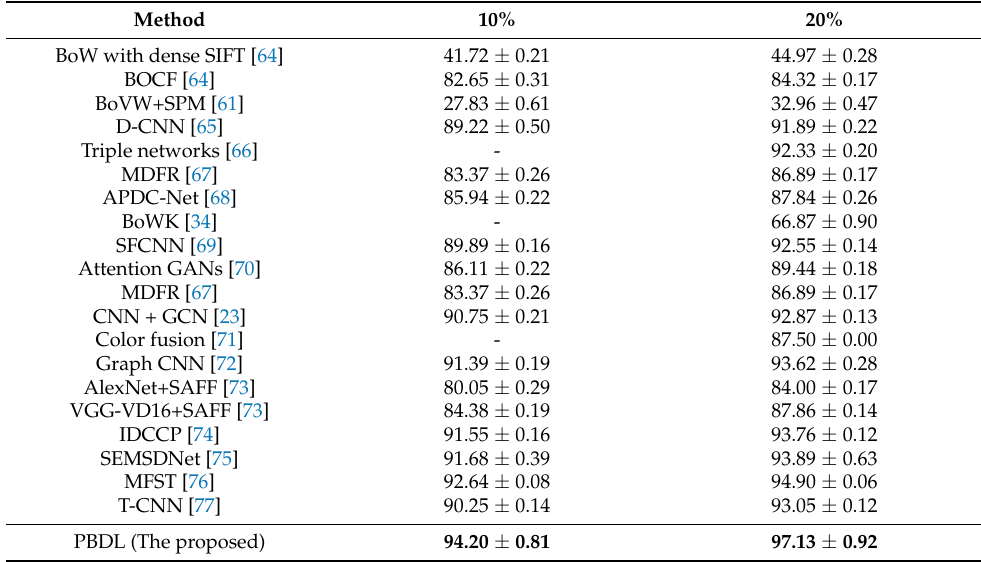
Table 5. Classification accuracy (%) for the NWPU dataset with two training ratios.The results are obtained directly from the corresponding